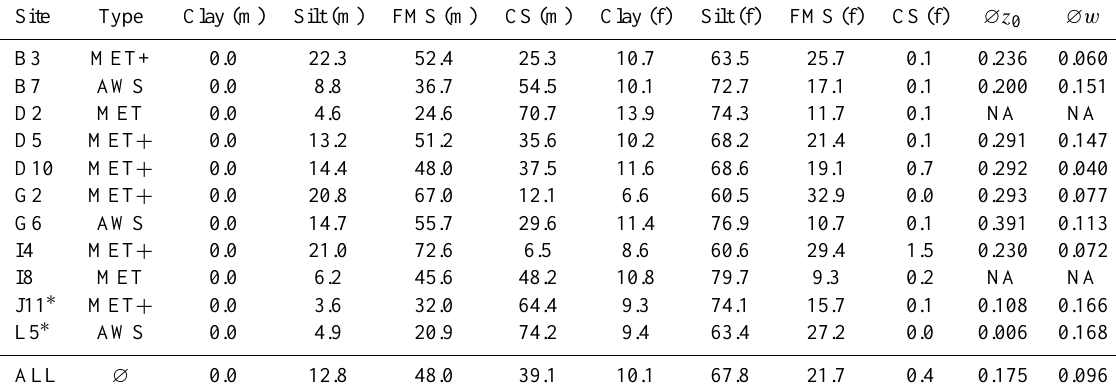
Table 1. Minimally and fully disturbed soil size distribution for each field site at Sua Pan. The mass fraction (in percent) for each parent soil type is given. FMS is fine/medium sand and CS is coarse sand. (m) refers to minimally disturbed and (f) to fully disturbed soil. The non-emissive crust sample is used instead. The two right-hand columns are the average surface roughness ( ∅ z 0 in cm) and soil moisture content ( ∅ w in m 3 m − 3 ) at each site and averaged over the grid.